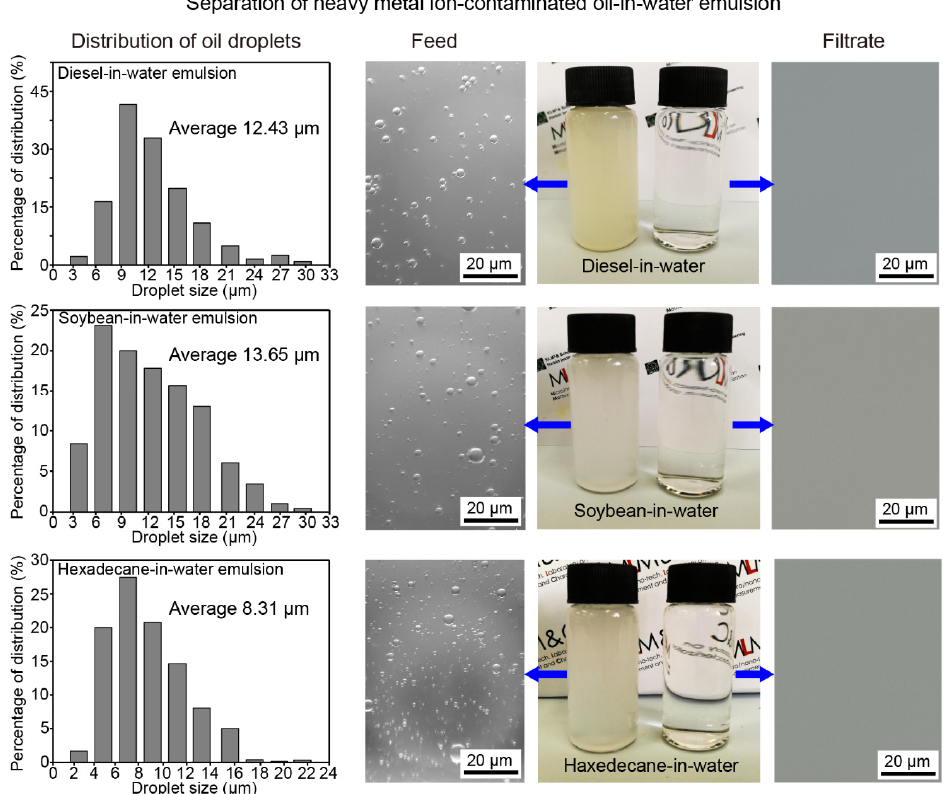
Figure 9. The effect of separation of contaminated diesel-in-water, soybean oil-in-water and hexadecane-in-water emulsions. Oil droplets which were smaller than 20 µm were detected in the feed before separation, whereas there were no droplets of oil detected in the filtrates.